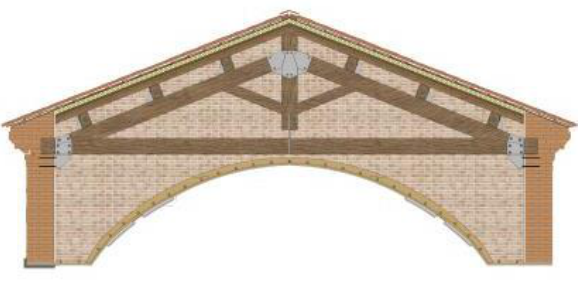
Figure 7. Roof construction details (by Onori F.)